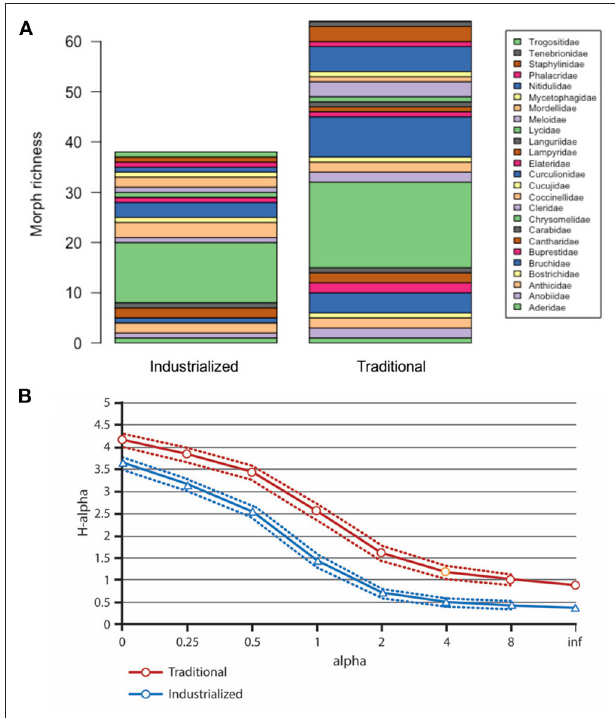
FIGURE 6 | Comparison of the industrialized vs. traditional compound samples. (A) Morph richness is strikingly higher for most of the families in the traditional group; (B) Renyi diversity is consistently higher in the traditional